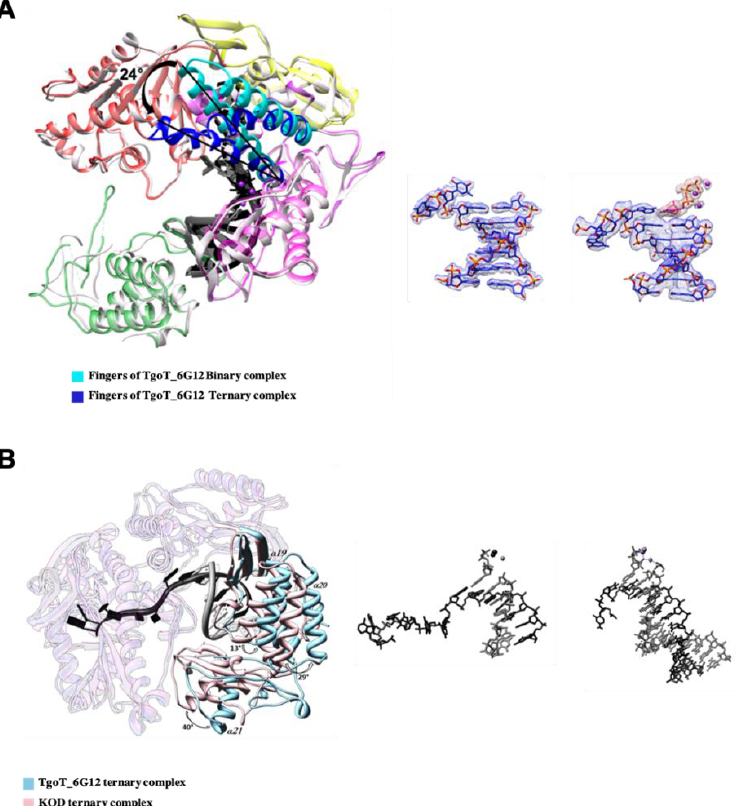
Figure 3. TgoT_6G12 polymerase conformational changes upon DNA and dNTP binding . ( A ) On the left, structural changes observed during nucleotide triphosphate binding are represented. The finger domain of the ternary complex (dark blue) is closed by approximatively 24 ◦ compared to the finger domain of the binary complex (cyan). On the right, the primer-template DNA duplex is represented, as observed in the binary and in the ternary complexes, respectively. The omit map electron densities of the primer-template, of the ddTTP, and of the three divalent ions are shown at 1 σ as a mesh and are labeled in blue for the primer-template and in pink for the ddTTP and the ions. ( B ) Comparison of the ternary structure of TgoT_6G12 and KOD polymerases. On the left panel, TgoT_6G12 polymerase is colored in light blue and KOD polymerase in light pink. The primer and template DNA strands are colored in grey and black, respectively. Helices α 19, α 20, and α 21 of the thumb domain in TgoT_6G12 are tilted outward by 13 ◦ , 29 ◦ , and 40 ◦ , respectively. On the right panel, the DNA / DNA duplex is represented, as seen in TgoT_6G12 ternary complex (on the left) and in KOD ternary complex (on the right), as stick. The primer strands, the incoming nucleotides and ions are labeled in dark grey while the template strands are labeled in